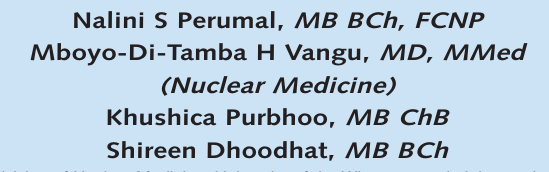
chilaiditti's.indd